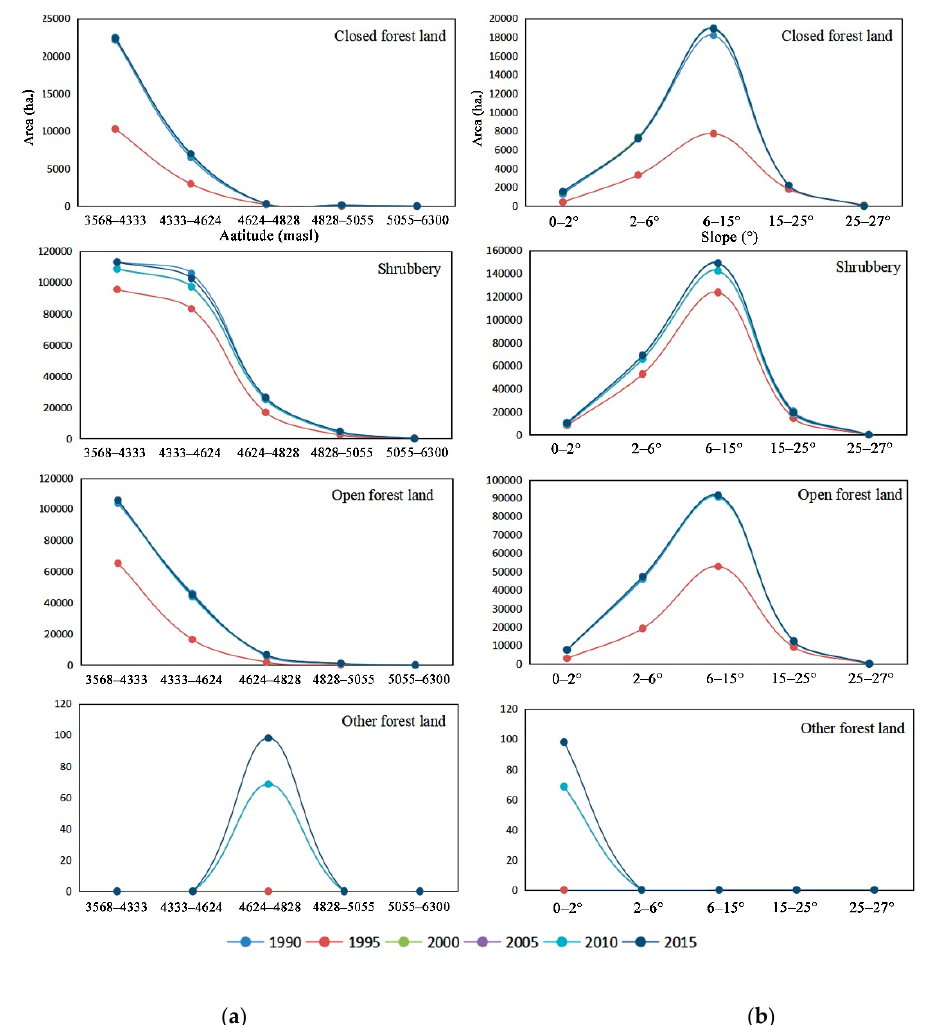
Figure 3. ( a ) Area distribution of forest landscape in different altitude ranges. ( b ) Area distribution of forest landscape in different slope ranges.